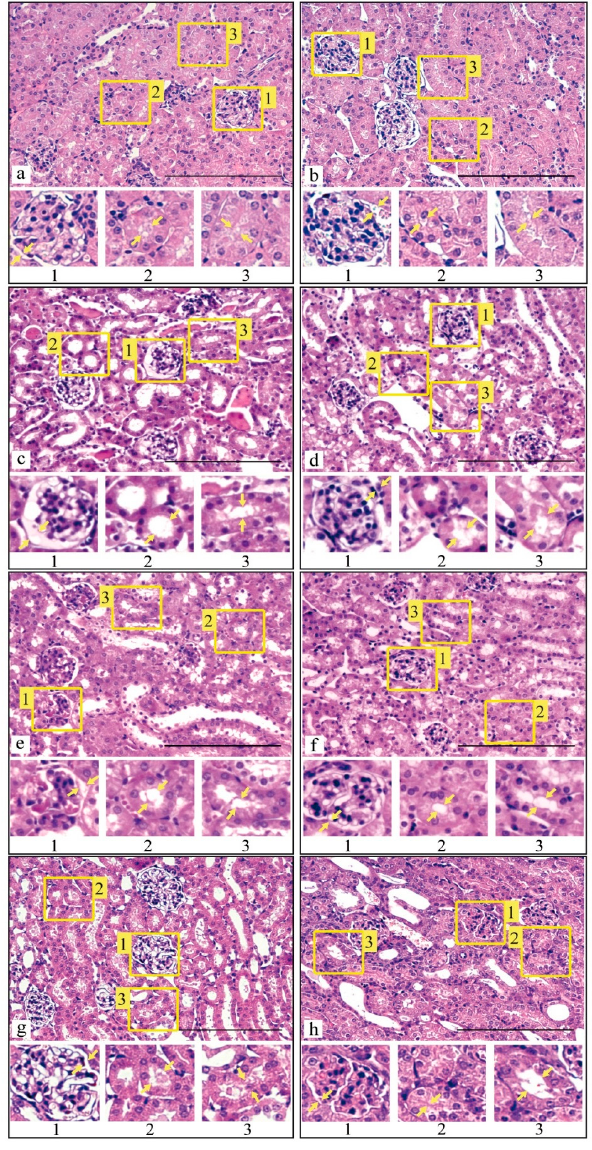
Figure 5. Structure of the cortical layer of mouse kidney after injection of recombinant peroxiredoxins followed by ischemia-reperfusion. 1—Glomerulus, 2—Distal tubules, 3—Proximal tubules. Arrows indicate areas of morphological changes. Intact control—( a ) and ( b ). The duration of ischemia was 30 min, the duration of reperfusion—24 h ( c ) and 72 h ( d ), without treatment. After intravenous injection of Prx1 15 min prior to 30-min ischemia, the duration of reperfusion was 24 h ( e ) and 72 h ( f ). After intravenous injection of Prx2 15 min prior to 30-min ischemia, the duration of reperfusion was 24 h ( g ) and 72 h ( h ). Staining: hematoxylin-eosin. Magnification: 500 ×. Scale: 200 µm. Morphological analysis of histological sections showed that 30-min ischemia and subsequent 24 h reperfusion of mouse kidneys leads to congestion of the interstitium and glomerular capillary loops in the control group. In the epithelium of the renal tubules, especially in convoluted tubules,